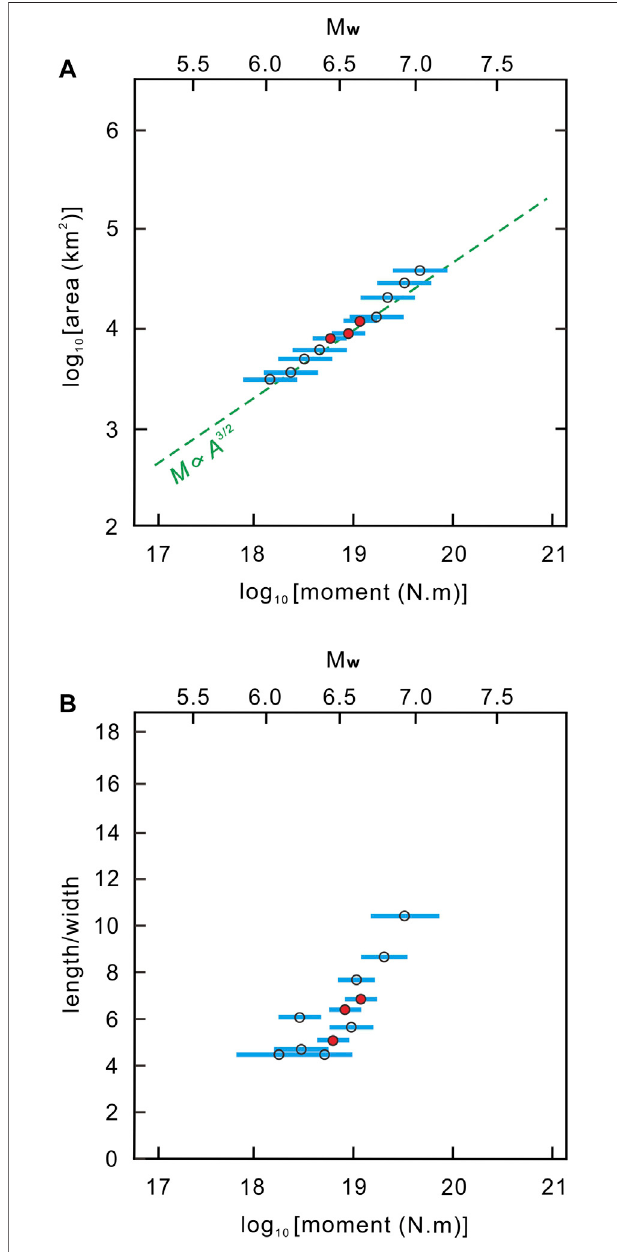
FIGURE 2 | Relationship between the moment and fault dimension of SSEs in the southernmost Ryukyu subduction zone. The red and hollow circlesrepresentthemeansoftheobservedand syntheticSSEs, respectively, which were derived from all bootstrapped samples. The 95 percent con fi dence intervals are shown by the blue horizontal bars. (A) Scaling of the faultareaandmomentsofSSEs. (B) TheaspectratioofthefaultareaofSSEs.